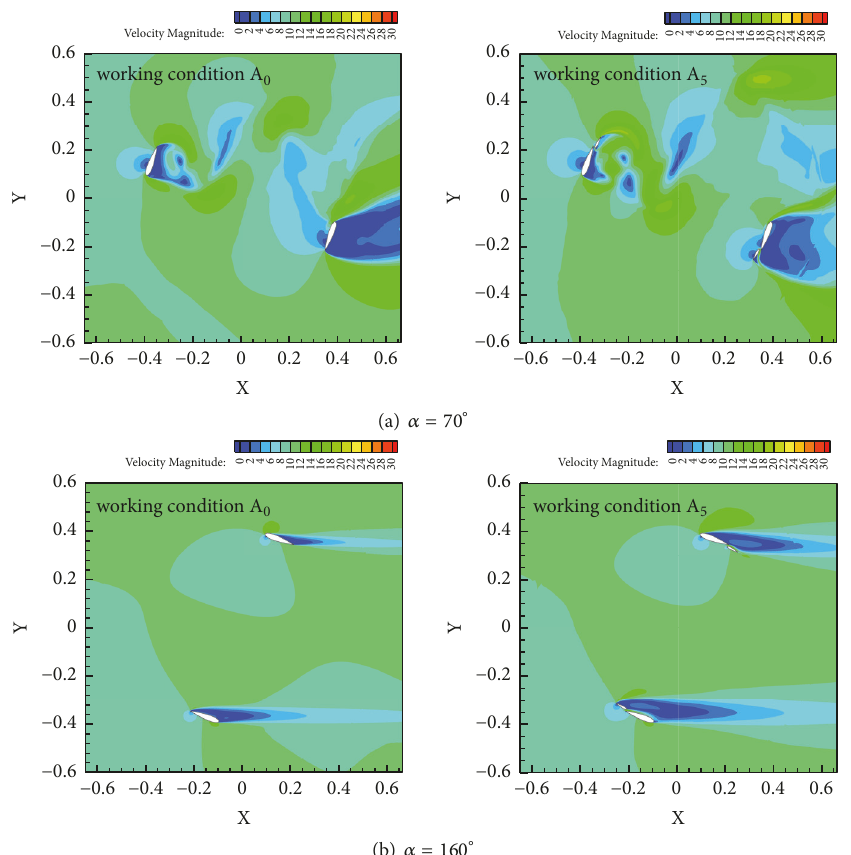
Figure 14: Static velocity contours at two azimuth angles of working condition